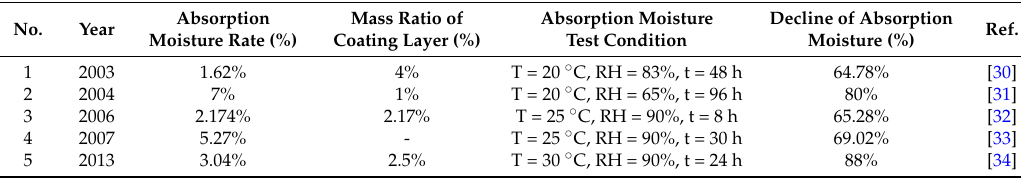
Table 1. Performance of coated AN using the physical coating